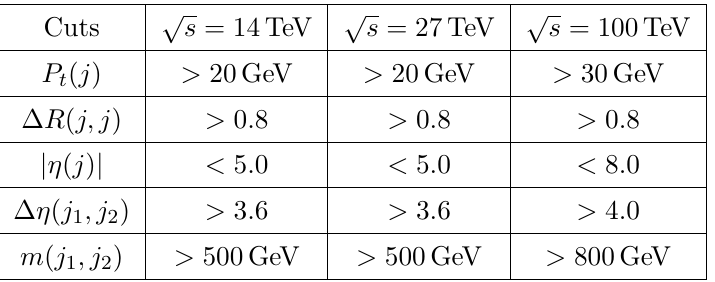
and j are the tagged forward jets for VBF 1 2